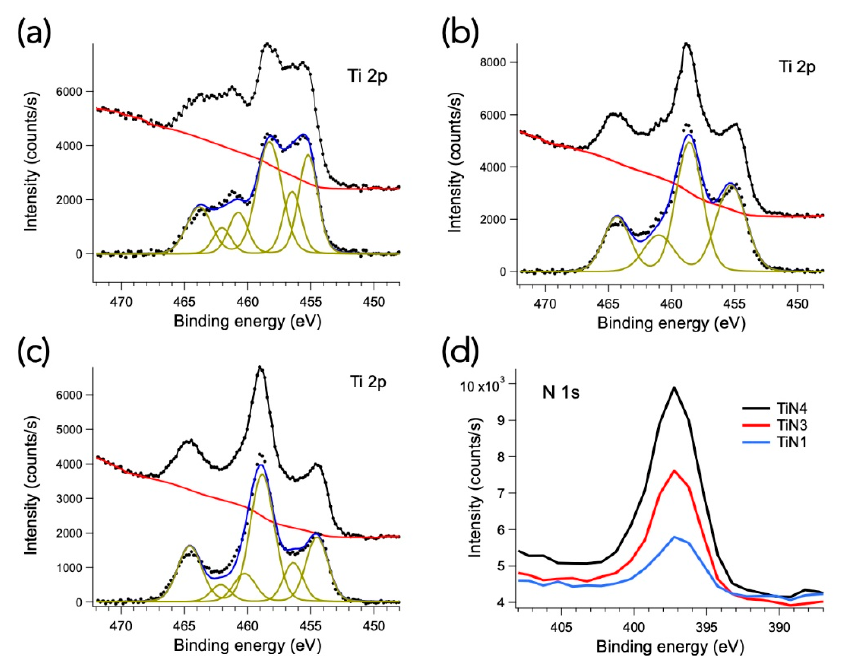
Figure 7. Ti 2p XPS spectra of TiN4 ( a ), TiN3 ( b ) and TiN1 ( c ) samples. The spectra are shown before and after a Shirley-type background (red curves) subtraction. The spectra are also shown decomposed into Voigt-doublets (green), according to the spin-orbit splitting of Ti 2p levels. Panel ( d ): N 1s spectra of the three samples (without background subtraction).